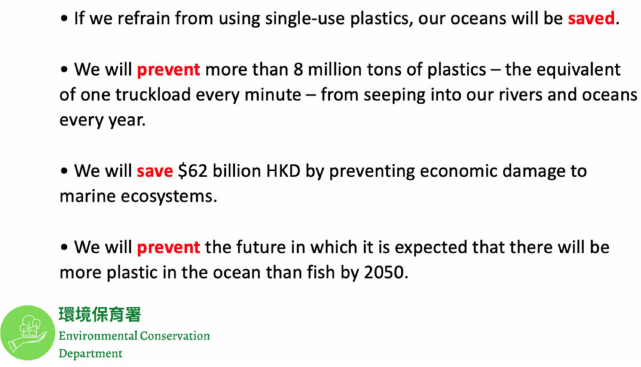
Figure A2. Example of condition 2: gain * text * government.